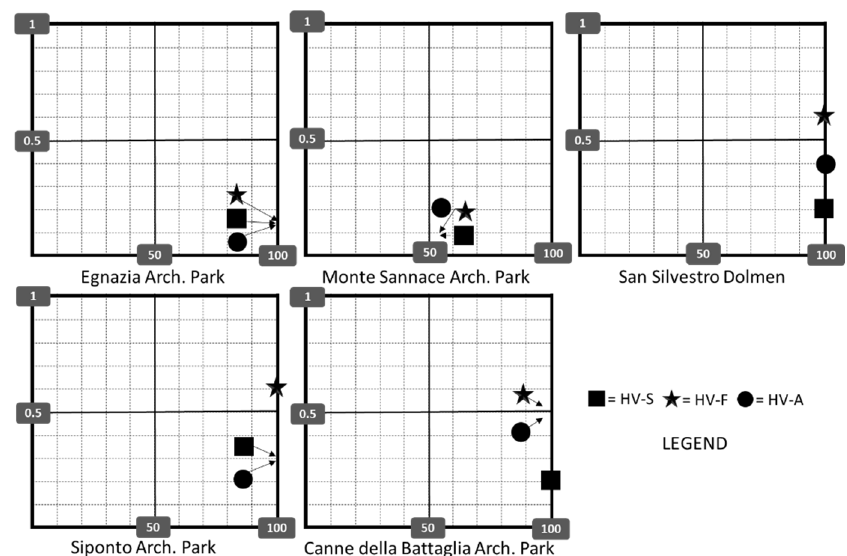
Figure 5. Diagrams describing weed impact in each site surveyed. The horizontal side of each square indicates the total weed coverage (%), while the vertical side reports the respective Index values.